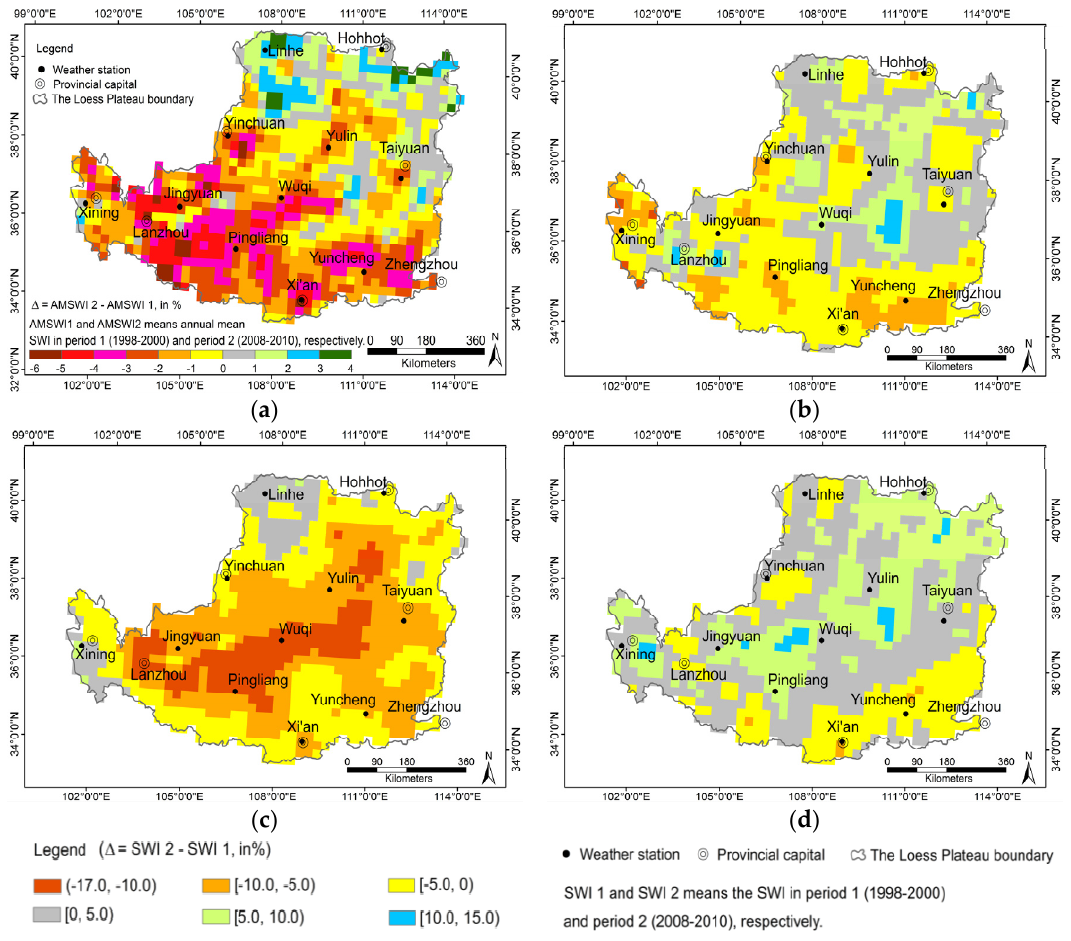
Figure 4. The spatial differences of mean annual SWI ( a ); the SWI for the three seasons (spring ( b